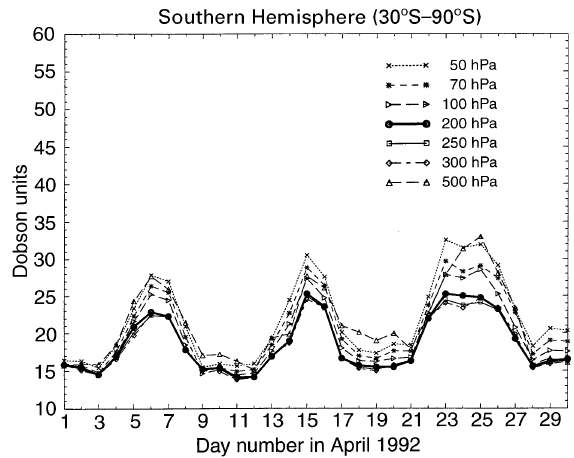
Fig. 7. As in Fig. 5 but only for the SH region (30 °— 90 ° S)